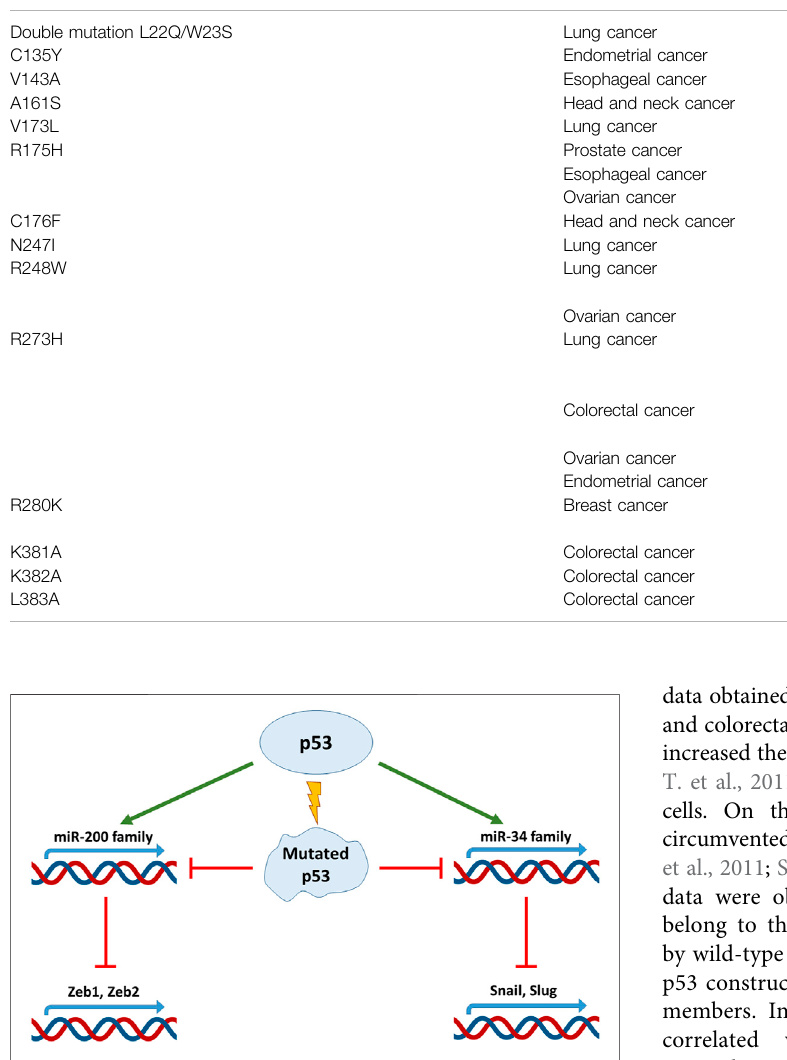
Frontiers in Molecular Biosciences |